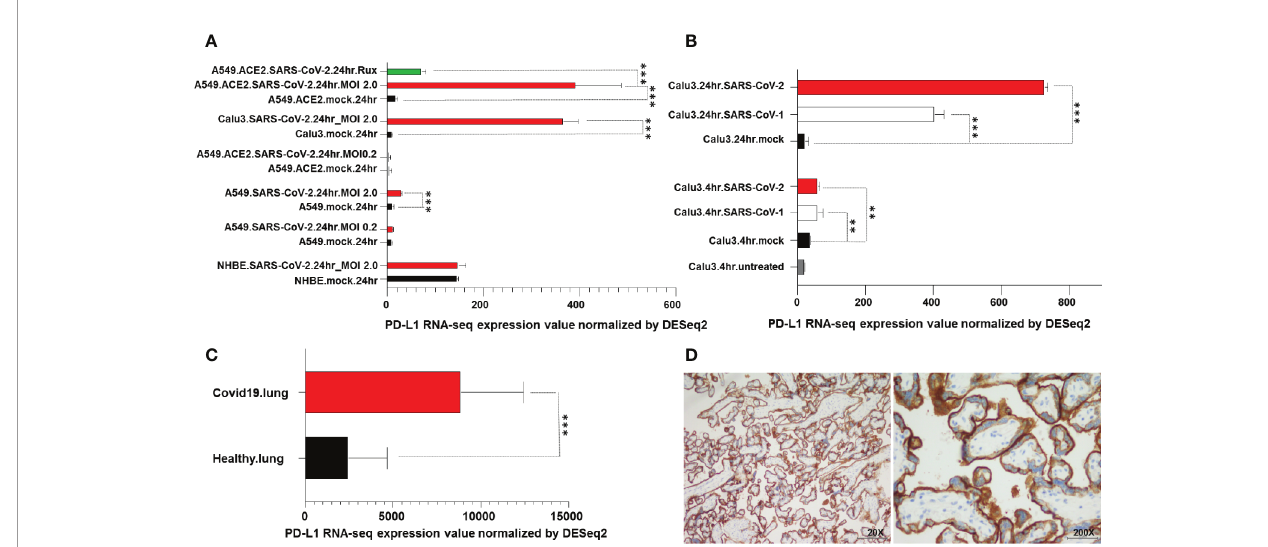
FIGURE 4 | PD-L1 upregulation in SARS-CoV-2 infected cells and in COVID-19 patient lung biopsies. (A) RNA levels of PD-L1 in A549, Calu3, NHBE cells, lung specimens derived from deceased COVID-19 and uninfected patients were downloaded from the GEO database and analyzed. A549, Calu3, NHBE cells were incubated for 24 hours with SARS-CoV-2 (A549.SARS-CoV2, Calu3.SARS-CoV2 and NHBE.SARS-CoV2) at different viral load (MOI). A549 cells were transduced with an expression vector encoding the human ACE2 protein (A549.ACE2), incubated for 24 hours with Sars-CoV-2 (A549.ACE2.SARS-CoV2) at different viral load (MOI) and treated with ruxolitinib (500 nM) (A549.ACE2.SARS-CoV2.Rux). Cells incubated with vector but without the virus (mock) were used as a control (A549.mock, Calu3.mock, NHBE.mock, A549.ACE2.mock). (B) Calu3 cells were incubated with SARS-CoV-2 or SARS-CoV-1 (Calu3.SARS-CoV2 and Calu3.SARS- CoV1) at different time points. Cells non incubated (Calu3.untreated) or incubated with vector but without the virus (Calu3.mock) were used as controls. (C) Lung specimens derived from COVID-19 patients were considered and compared to samples of uninfected human lung biopsies. RNA levels of PD-L1 were compared using Pairwise comparisons. ** and *** indicate p < 0.001 and < 0.01, respectively. (D) Representative staining patterns of FFPE bronchial aspirate with PD-L1- speci fi c mAb SP263 of a COVID-19 patient. IgG was used as an isotype control for PD-L1 staining (data not shown). Magni fi cation is